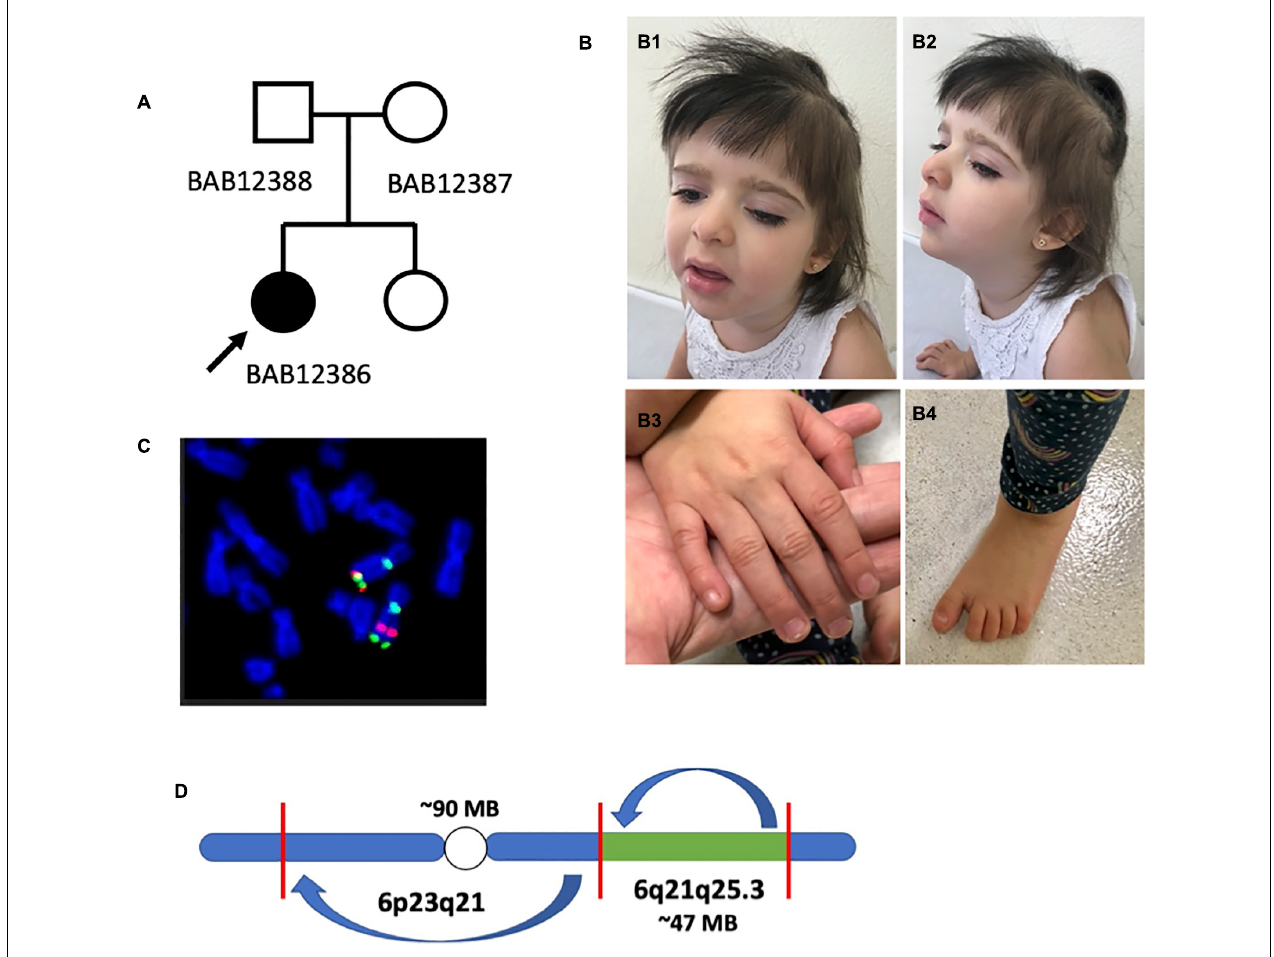
FIGURE 1 | Preliminary analysis of proband and chromosome 6 rearrangement. (A) Pedigree structure with the father (BAB12388), mother (BAB12387), and proband (BAB12386) as well as an unaffected sister (not enrolled). (B) Female proband (BAB12386) highlighting mildly dysmorphic facies and typical hand features. (B1,B2) Frontal and lateral view of the proband at the age of 4 years showing thick hair with sparseness in the temporal region, bushy eyebrows and long eyelashes, left palpebral ptosis, and full lips with eversion of the lower lip. (B3,B4) Right hand and foot depicting normal nails and increased distance between the hallux and second toe (sandal gap sign). (C) Fluorescence in situ hybridization (FISH) analysis confirming apparent pericentric and paracentric inversions present on chromosome 6 as first detected by karyotyping analysis. (D) Initially proposed chromosome 6 structure with a ∼ 90-Mb and ∼ 47-Mb inversion both present on chromosome